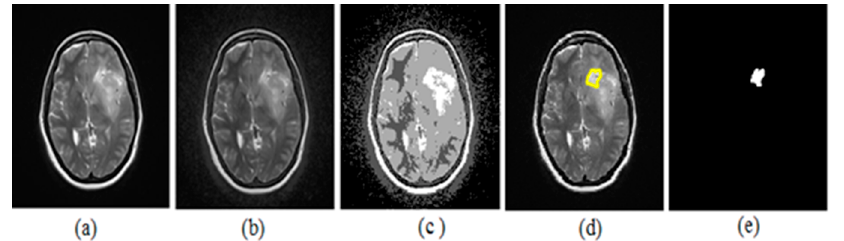
Figure 10. ( a ) Original image, ( b ) BPDFHE enhanced image, ( c ) segmentation result using median filter, ( d ) detection of tumor, and ( e ) extraction of tumor using thresholding.